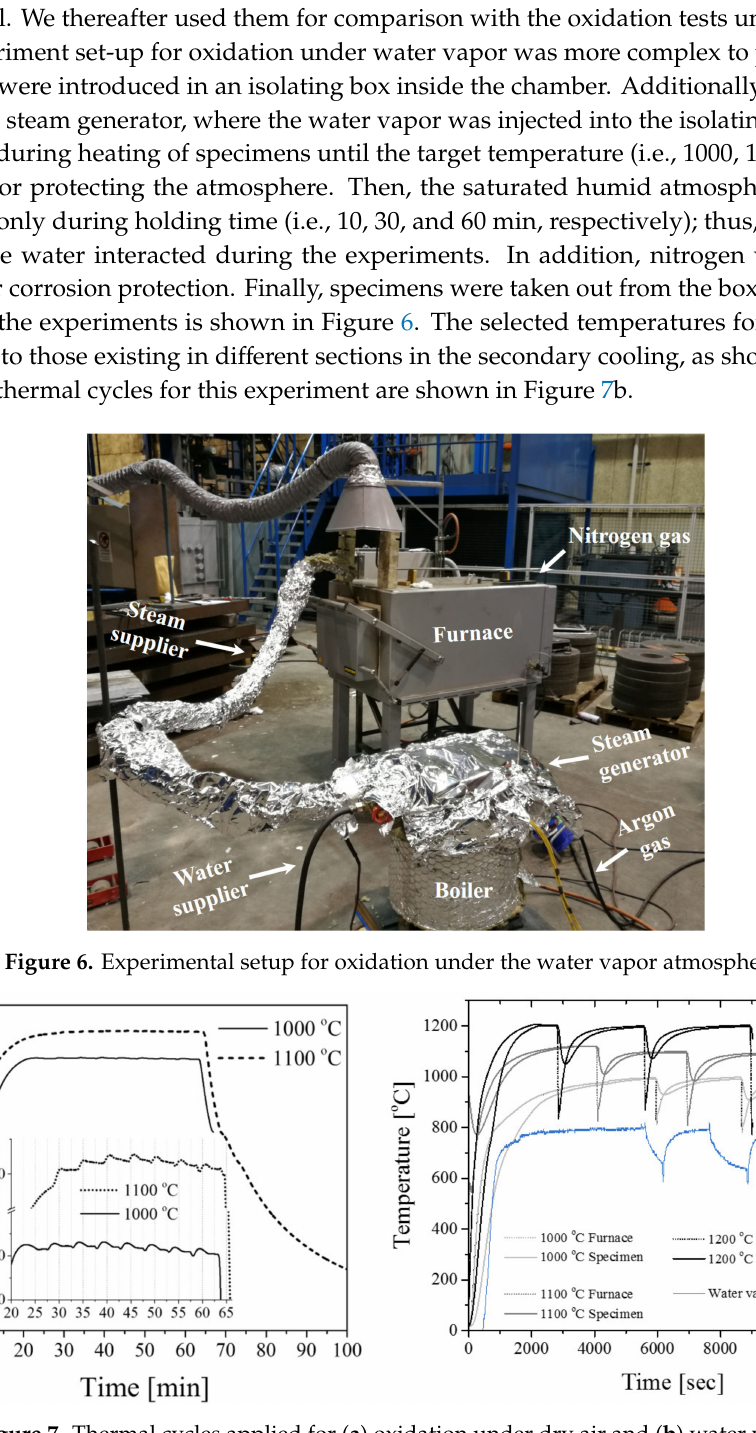
Figure 7. Thermal cycles applied for ( a ) oxidation under dry air and ( b ) water